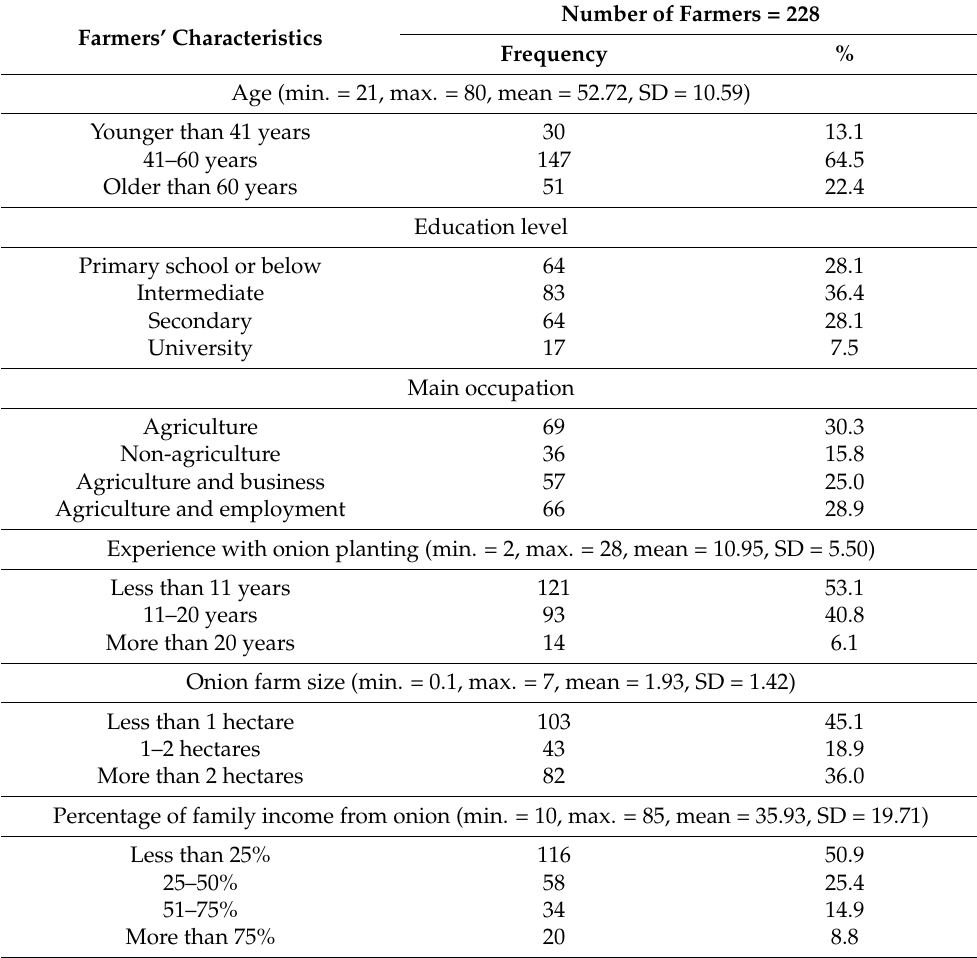
Table 2. Descriptive summary of farmers’